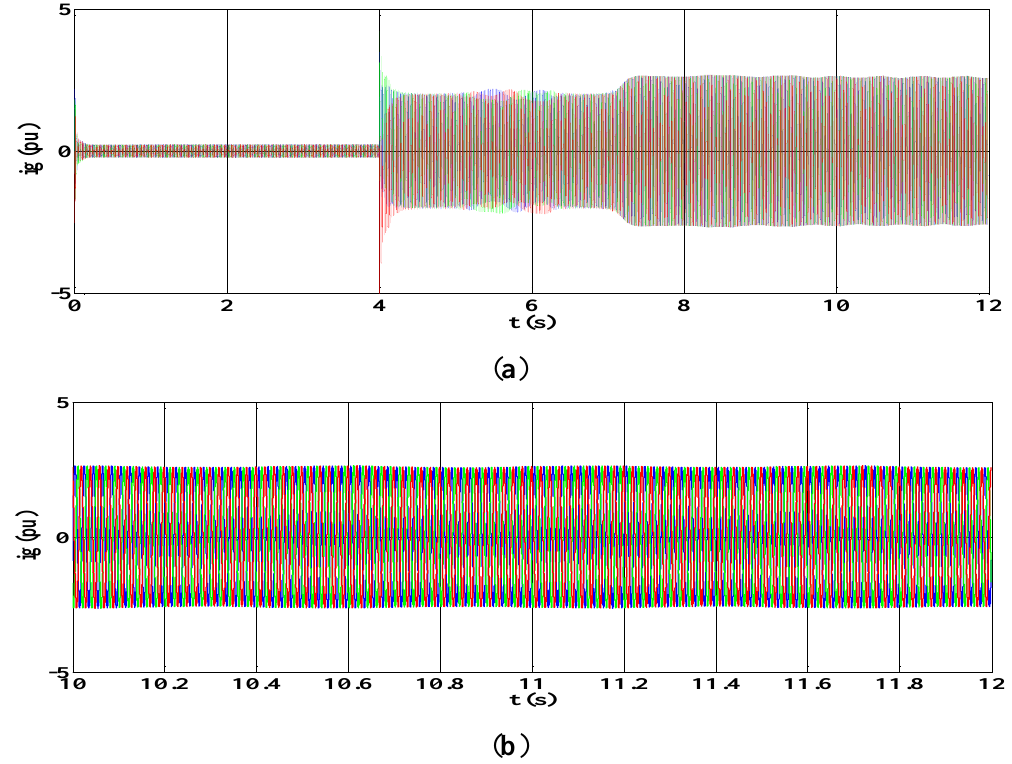
Figure 35. ( a ) Grid Side Converter (GSC) line currents (short-circuit happens at t = 4 s), ( b ) zoom of (a).